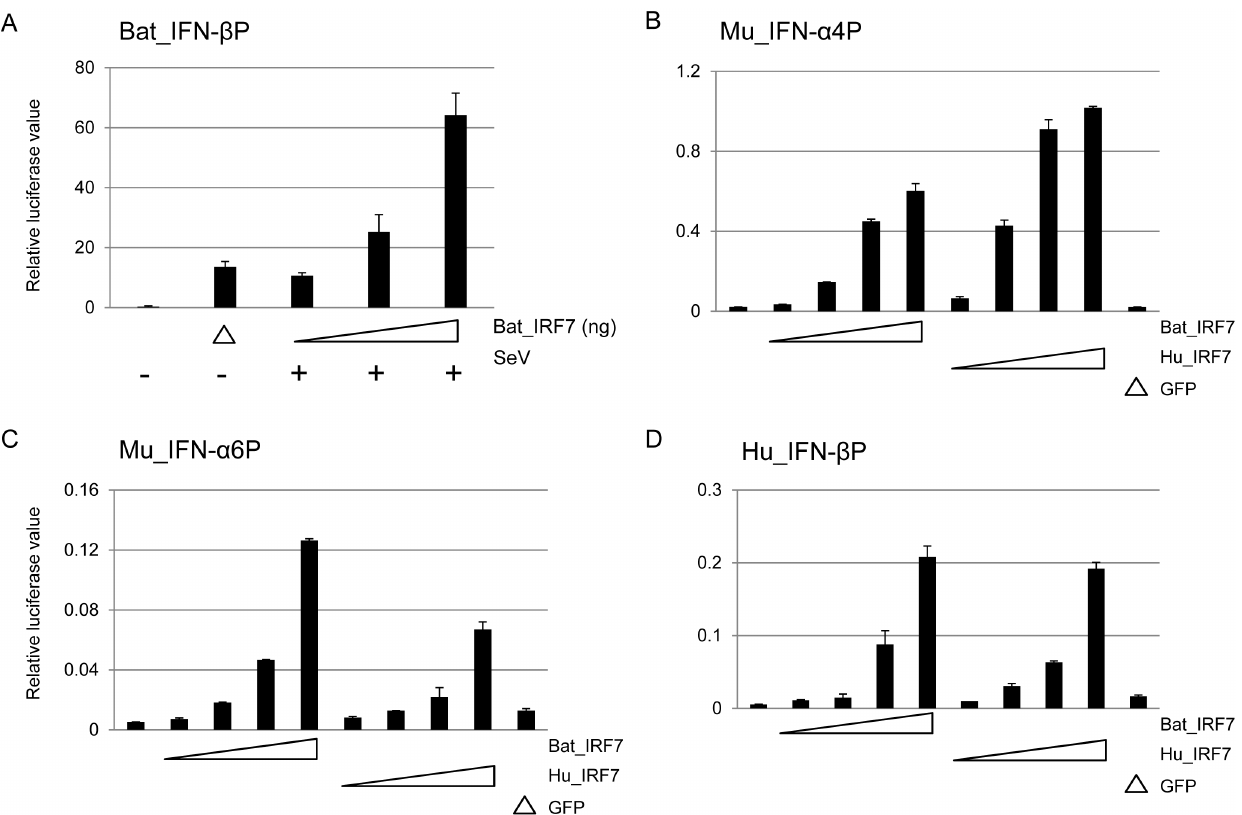
Figure 3. IFN- b is induced in a dose-dependent manner by bat IRF7. (A) Sendai virus (SeV) induced higher IFN- b induction with an increasing dose of bat IRF7. Bat PaKiT03 cells (2 6 10 5 per well) were cotransfected with 0, 10, 50 or 100 ng pCAGGS-bat IRF7 (left to right, last three bars) and bat IFN- b promoter plasmid. 24 h post-transfection, cells were infected with 100 HAU SeV per well or mock infected (left to right, first two bars, D indicates transfection with 100 ng pCAGGS-bat IRF7) followed by promoter activation assay six hours after infection. Values show the mean of two experiments and error bars indicate standard errors. (B–D) HEK293T cells were transiently transfected with 0, 1, 10, 100 or 500 ng of expression plasmids for either bat (left to right, first five bars) or human IRF7-GFP (next four bars) with mouse IFN- a 4 (B) IFN- a 6 (C) or human IFN- b (D) promoter plasmid. GFP expression plasmid was used at 500 ng per well as negative control. After 30 h, cells were analysed for promoter activity by reporter gene assay. Similar results were obtained in two independent experiments. Values show the average of two experiments and error bars indicate standard errors.